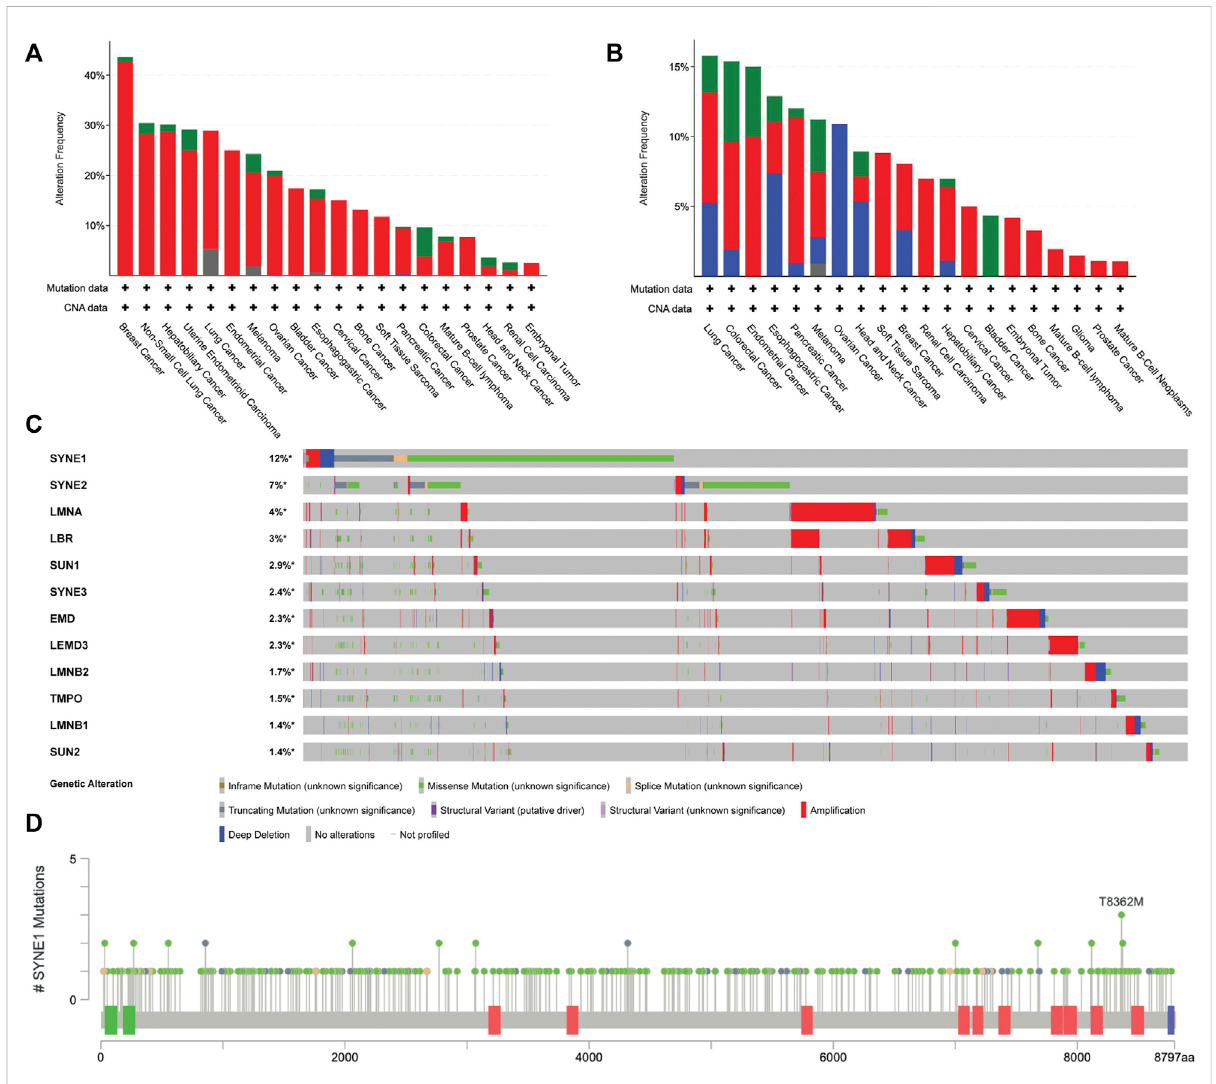
FIGURE 3 Analysis of genetic alterations in nuclear envelope genes in cancer patients using cBioPortal data (ICGC/TCGA Pan-Cancer Analysis of Whole Genomes Consortium 2020) CNAs in (A) LMNA (B) LMNB (B1 and B2) (C) Oncoprint of 10 nuclear envelope genes across 10967 cancer patient samples arranged in descending order based on the frequency of missense mutations (D) Localization and frequency of SYNE1 mutations in cancer patients using lollipop plot of cBioPortal (Cerami et al., 2012; Gao et al., 2013).